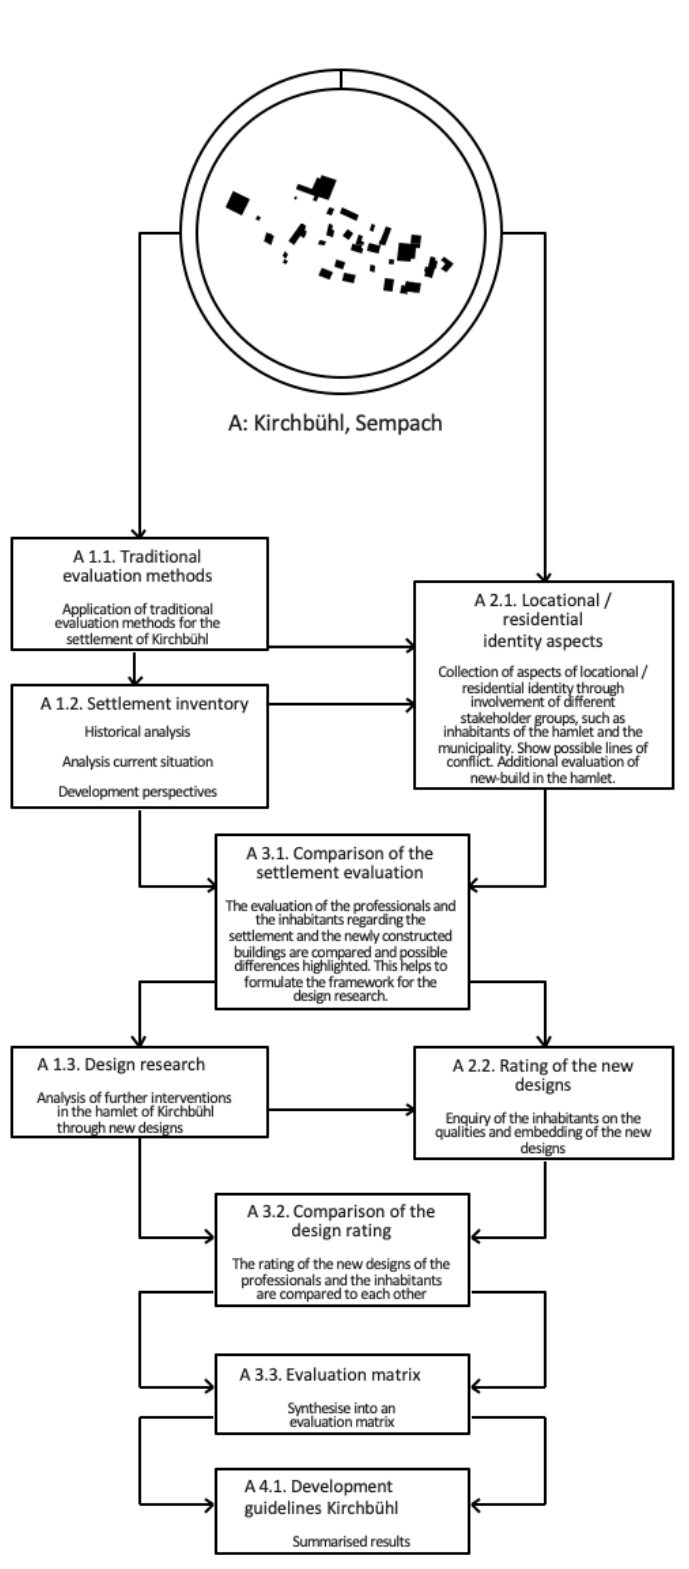
Figure 6: Methodology for the Kirchbühl